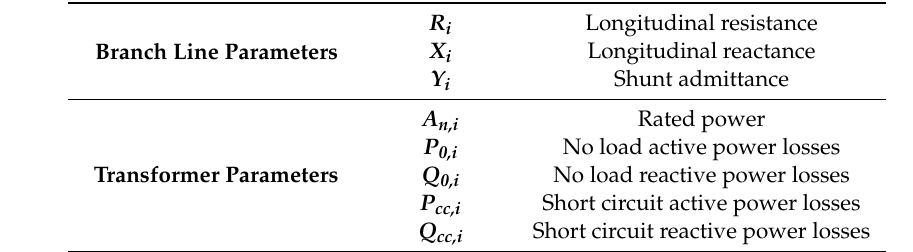
Figure 3. Scheme of the i -th brunch of the network model. Table 1. Required network parameters.